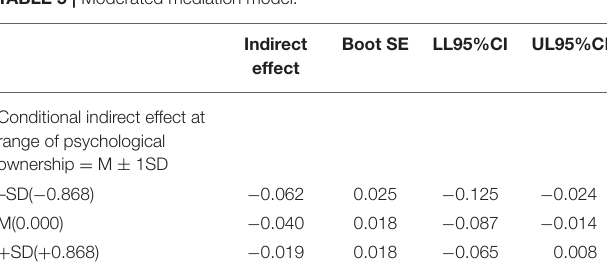
TABLE 5 | Moderated mediation